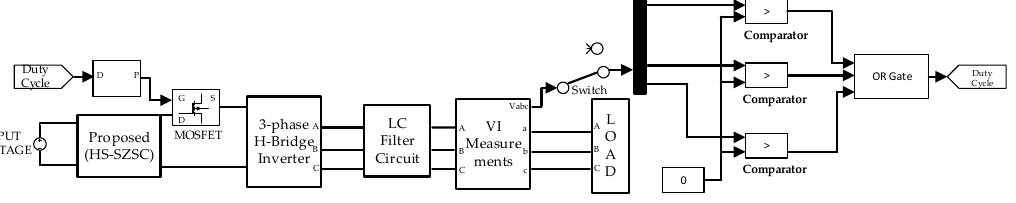
Figure 15. The block diagram representation of the model to address the islanding issue of GCIs. In this model, a MOSFET is utilized with the switched converter at the output side. During the no-load condition, the manual switch is activated by the logically compared output, which operates MOSFETs accordingly. Hence, no current flows through the line during the no-load condition as shown in Figure 16. Figure 16. The output of the inverter during a sudden loss of the load.